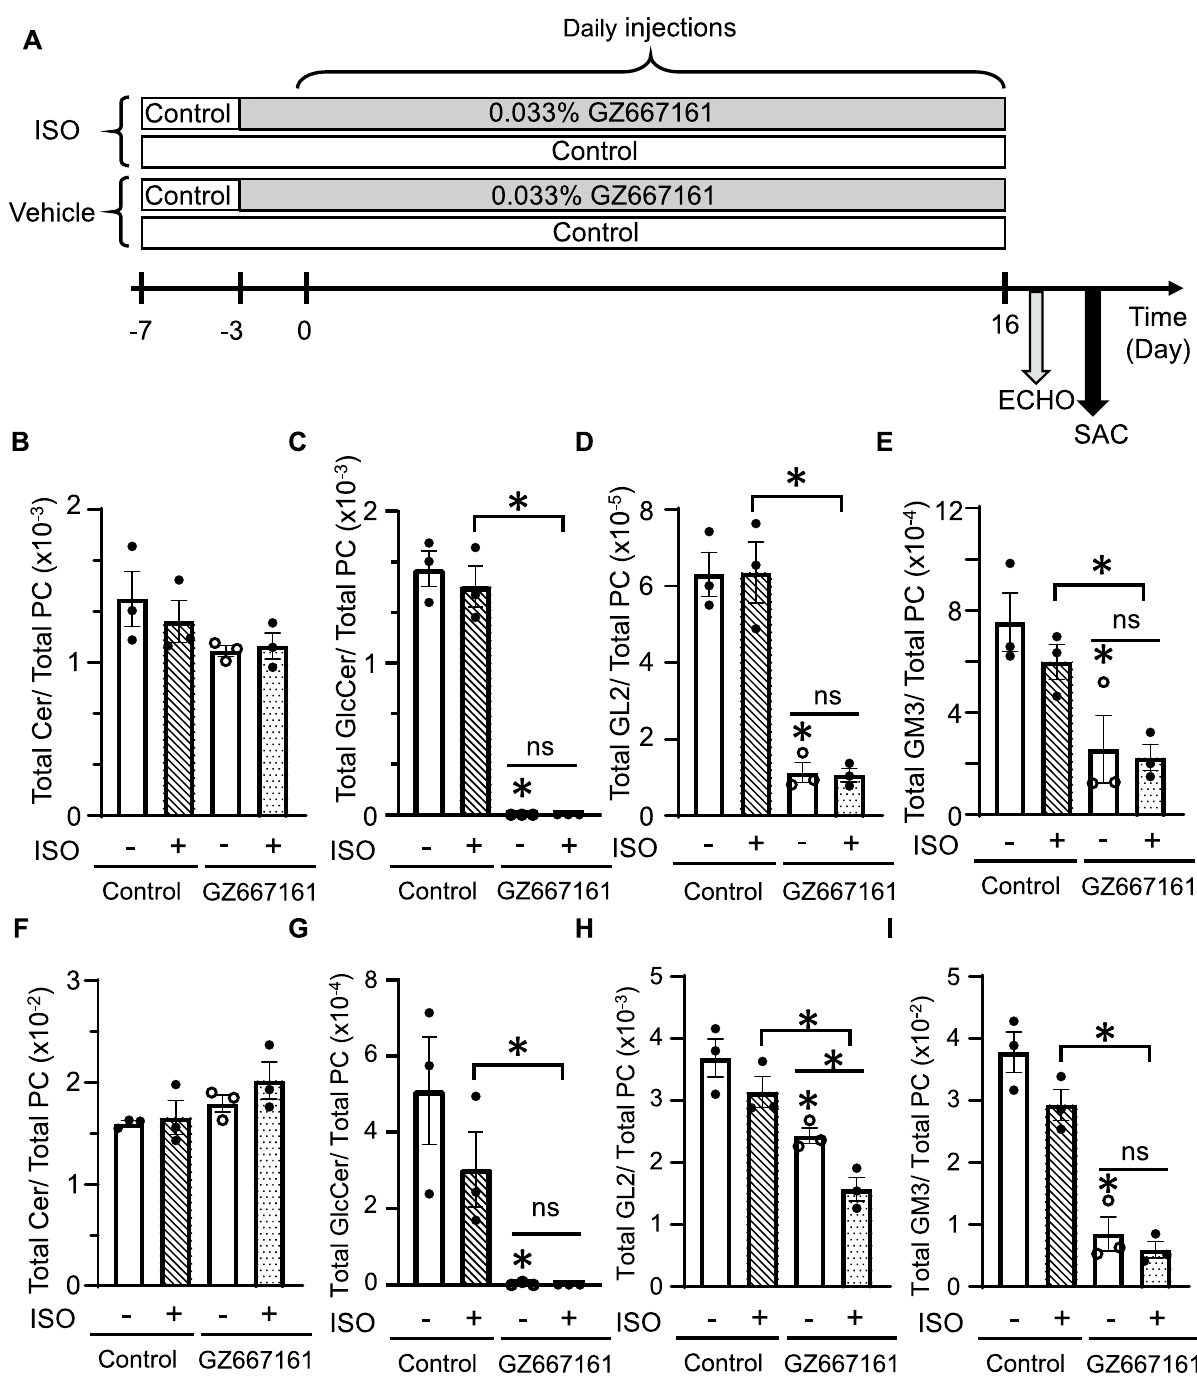
Figure 2. GZ667161 decreases GSL levels in the plasma and heart tissue of +/− ISO treated mice. ( A ) Diagram of experimental design. ( B ) Total ceramide levels normalized to phosphatidylcholine (PC) in plasma. ( C ) Total Glucosylceramide (GlcCer) normalized to control lipid PC in plasma. ( D ) Total GL2 levels normalized to PC. ( E ) Total ganglioside GM3 in plasma normalized to PC. ( F ) Total ceramide levels normalized to PC in heart tissue. ( G ) Total Glucosylceramide (GlcCer) normalized to control lipid PC in the heart tissue of +/− ISO mice. (H) Total GL2 levels normalized to PC. ( I ) Total ganglioside GM3 in the heart normalized to PC. * P < 0.05 between indicated groups or − ISO control. ns not significantly different between indicated groups. Mice were fed control or 0.033% wt/wt GZ667161 diet. (n = 3 per group) Data is expressed as mean ±